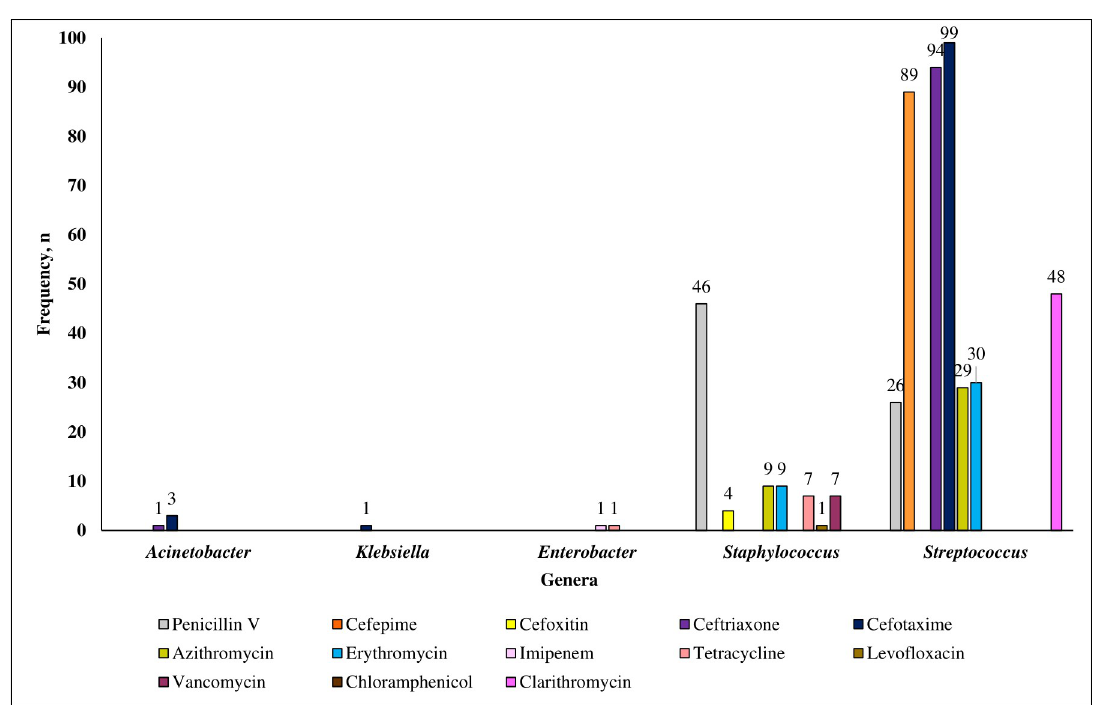
Fig 2. Antibiotic-resistant non-repetitive isolates found in AP patients.